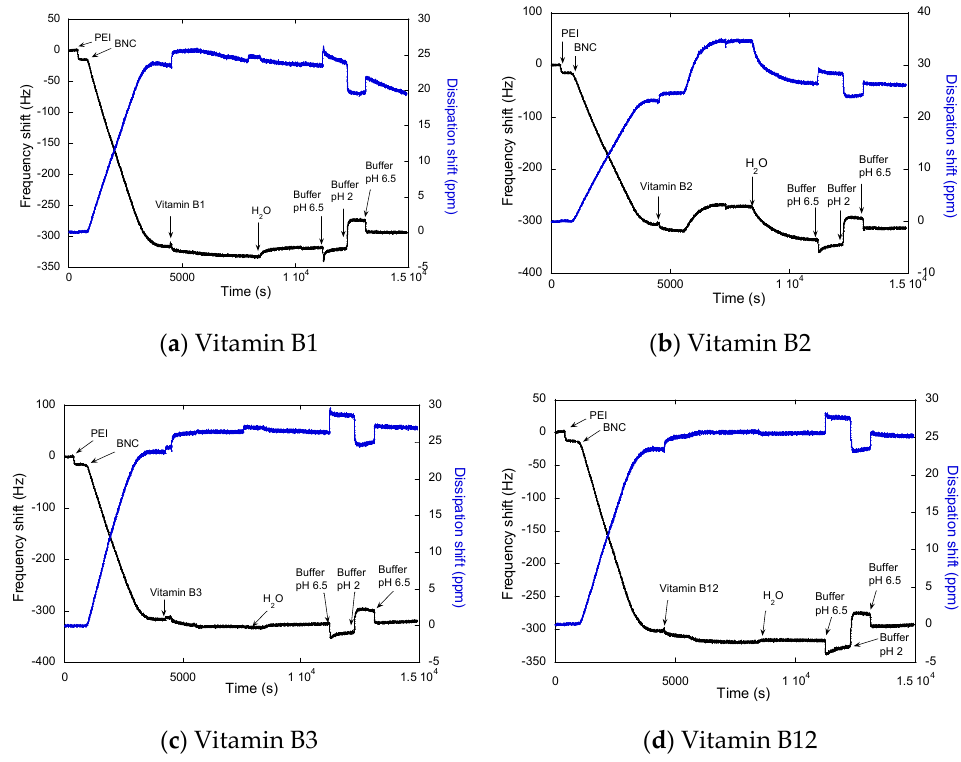
Figure 4. QCM-D plots for desorption of vitamins (( a ) B1, ( b ) B2, ( c ) B3, and ( d ) B12)) by using pH 2 and pH 6.5. Δ F = change in frequency (black line) and Δ D = dissipation (blue line).